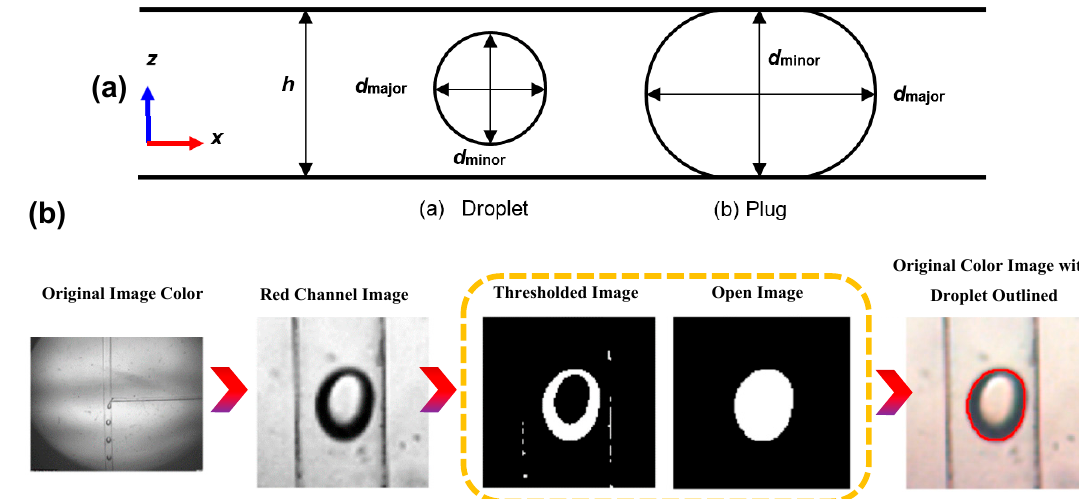
Figure 3. Algorithm of optimizing the design precision of xurographic microchannel.